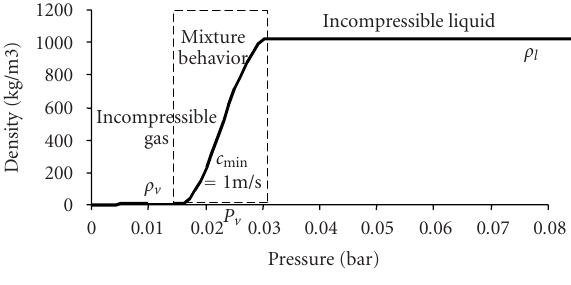
Figure 3: The barotropic state law ρ ( P ) for